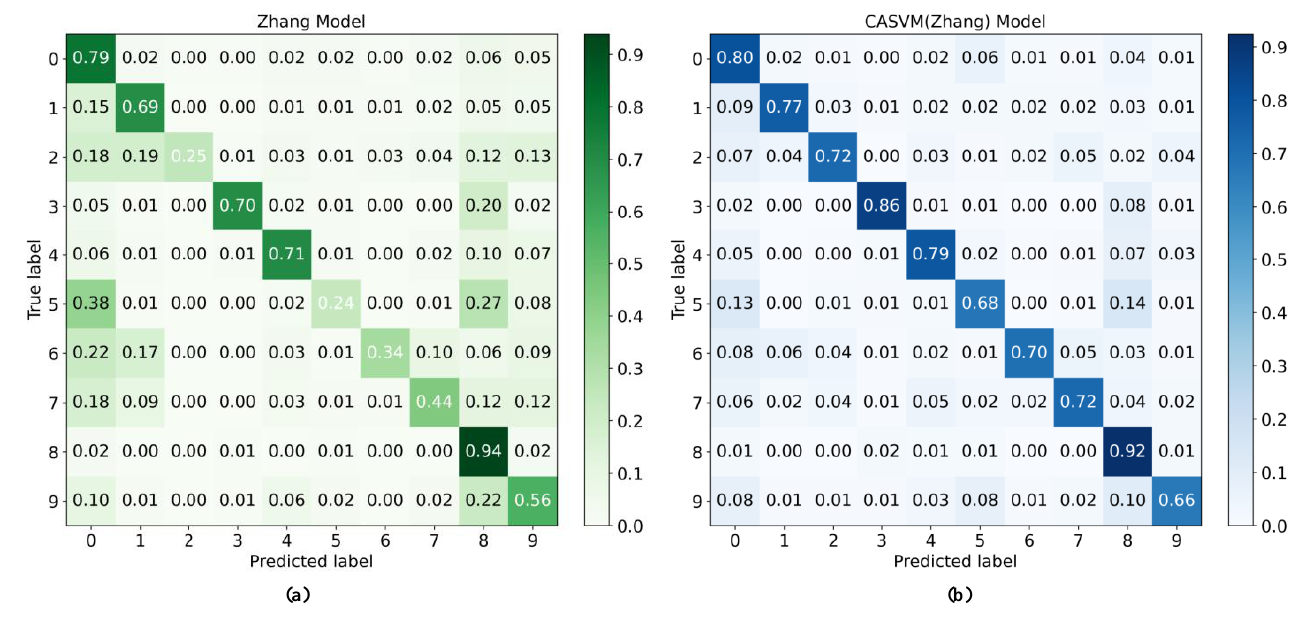
Figure 9. Confusion matrix: ( a ) The model of Zhang et al. [43]; ( b ) The model of CASVM (Zhang et al.). Table 9. Performance metrics of different models on the Animal10